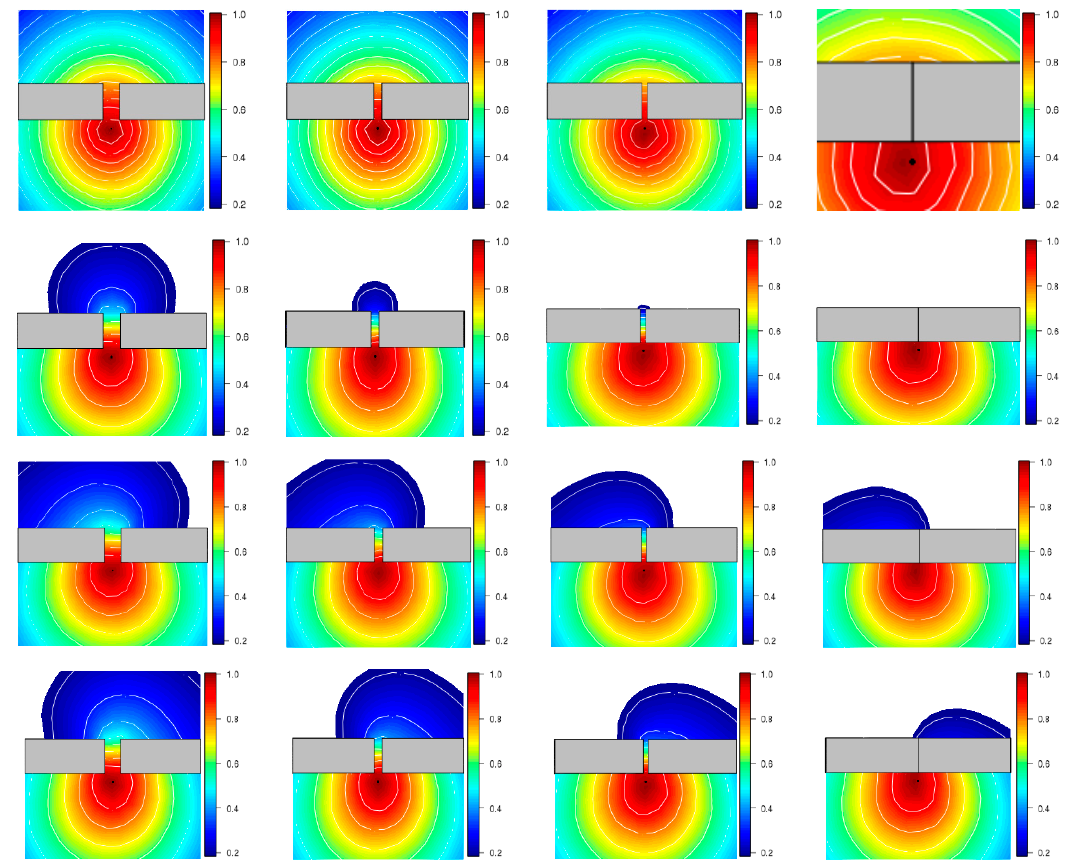
Figure 4. Changes in the correlation between the points in the three models in the areas. Note: The four graphs in the first row represent the changes in the correlation between the points in the stationary Gaussian model and those in the second row display the changes in the correlation between the points in the barrier model. The graphs in the third and fourth rows manifest the changes in the correlation between the points in the Multi-Barriers Model under different thresholds. The distances between the obstacles in the first column and the fourth column are 1, 0.5, 0.3, and 0, respectively.